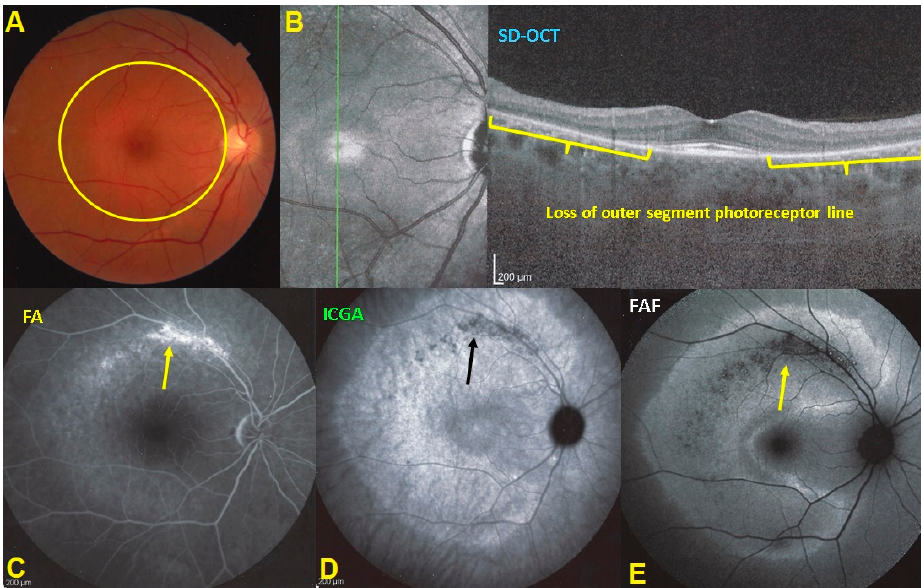
Figure 14. Imaging illustration of the clinicopathology of AZOOR. ( A ) Fundus shows a pale discol- ored halo around the fovea that retains a normal color (yellow circle) due to loss of photoreceptor photopigment. ( C ) FA OD shows the same halo of discreet hyperfluorescence due to photopigment loss and an area of bright hyperfluorescence (window effect) along superior temporal arcade due to chorioretinal atrophy (dark on ICGA— D , black arrow- and FAF— E , yellow arrow). ICGA ( D ) shows preserved choriocapillaris (except in the arciform area of chorioretinal atrophy-black arrow) with increased fluorescence in the area of loss of the screen of photopigments, which also explains